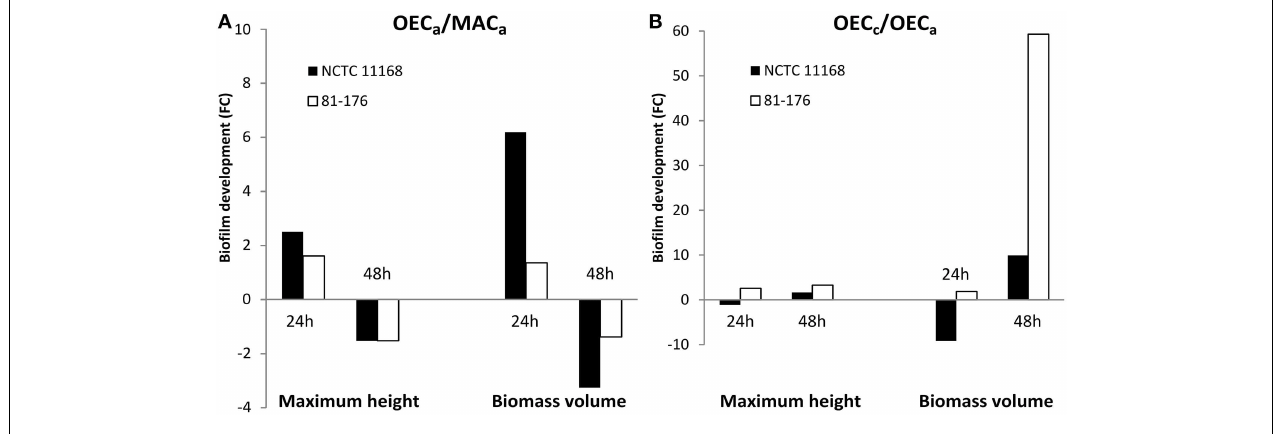
to OEC (OEC a : 19% O 2 , 10% CO 2 , 71% N 2 ) and to MAC (MAC a : 5% O 2 , 10% CO 2 , 85% N 2 ) prior to biofilm formation in MAC. (B) FC of biofilm development of cells submitted to OEC (OEC c ) during biofilm cultivation and cells submitted to OEC (OEC a ) prior to biofilm cultivation in MAC. Statistical data are presented in Supplementary Tables 2,